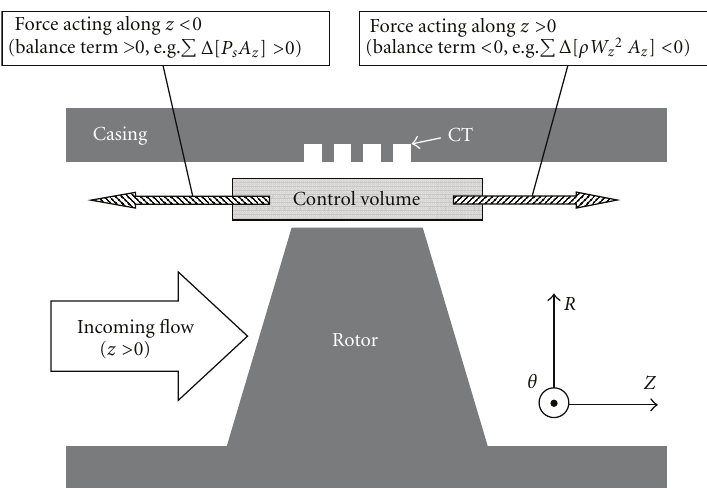
Figure 22: Nomenclature and sketch of the axial forces acting on a control volume located in the rotor tip